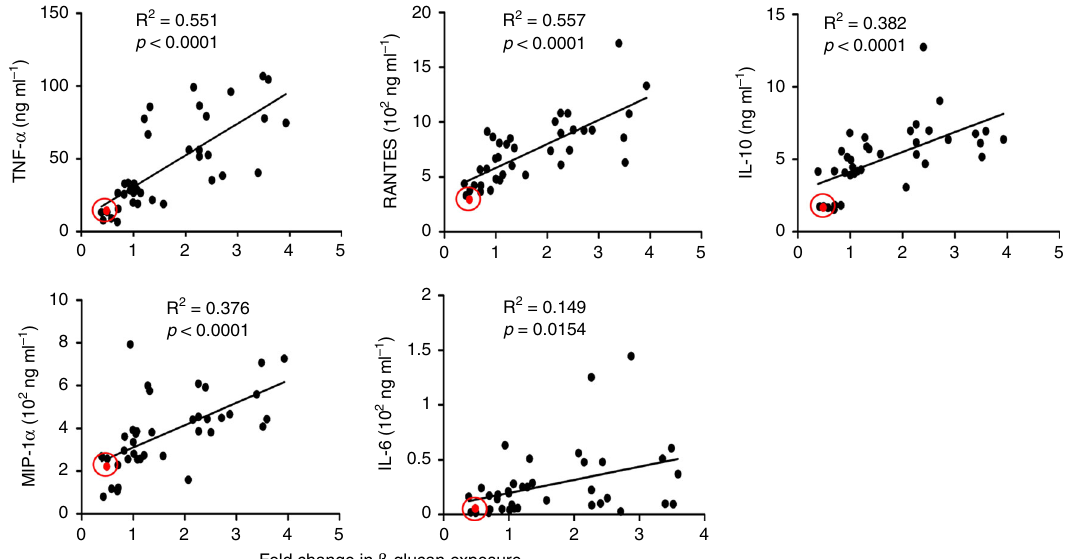
Fig. 3 C. albicans β -glucan exposure correlates with PBMC cytokine responses. Wild type C. albicans cells (SC5314: Supplementary Table 1) were grown under the conditions described in Figs. 1, 2 and fi xed. These C. albicans cells were then mixed with human PBMCs (duplicate samples from six different individuals) at a ratio of 5:1 (yeast:PBMCs). TNF α , RANTES, IL-10, MIP-1 α , and IL-6 levels were assayed after 24 h. These data were then plotted against the fold change in β -glucan exposure triggered by each environmental condition. Each data point represents the mean of duplicate samples from four different individuals. The correlation between these parameters was tested by linear regression using the software GraphPad Prism 5. The results for iron limitation are highlighted in each graph (red dot highlighted by red circle). Source data are provided as a Source Data fi